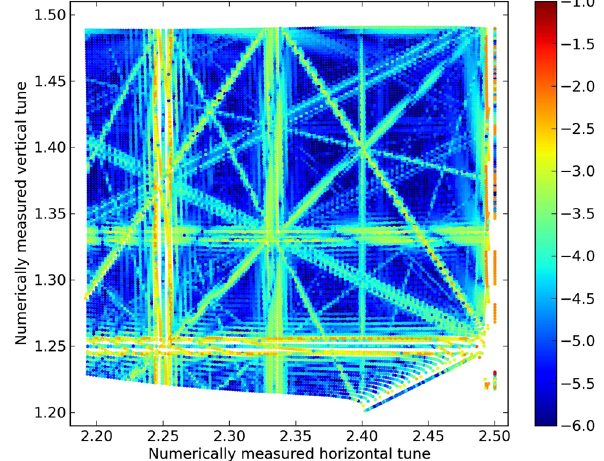
FIG. 5. D plotted as colors against the numerically measured tunes for the bare ELENA machine, consisting of only the main bendings and the three quadrupole families.